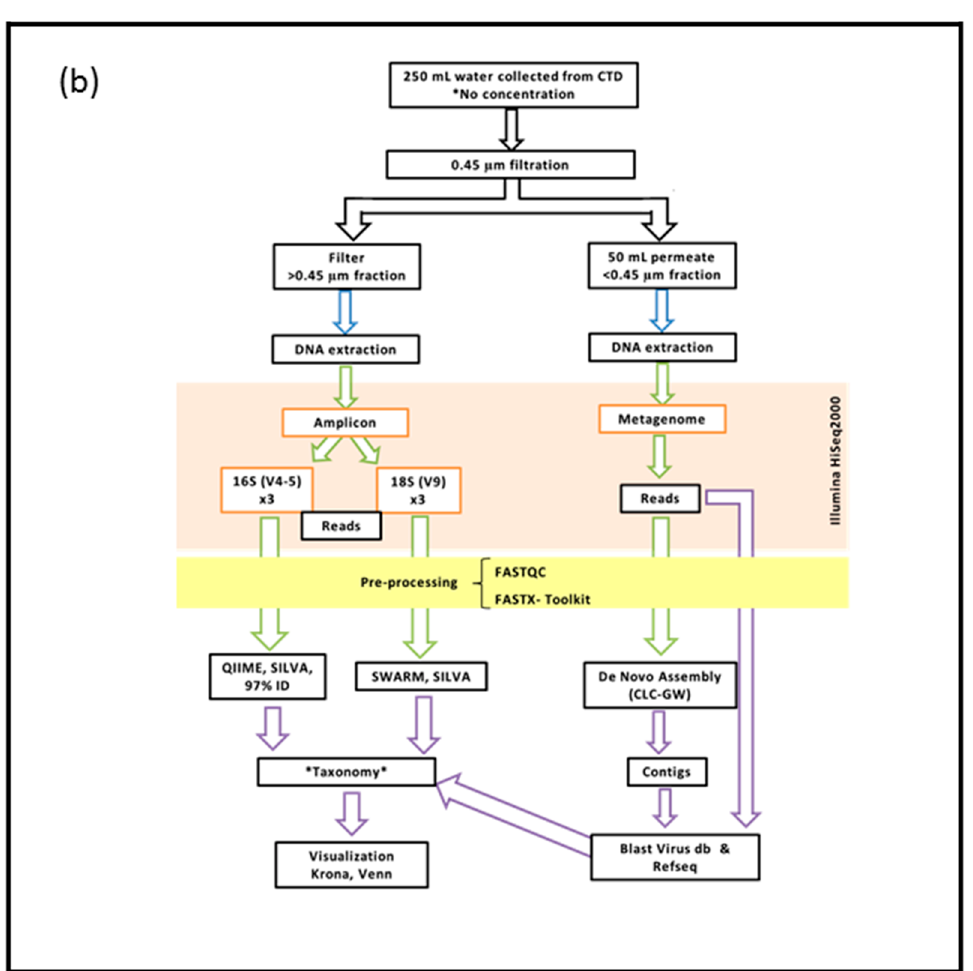
Figure 1. ( a ) Map showing the location of sample collection; ( b ) schematics of the bioinformatics